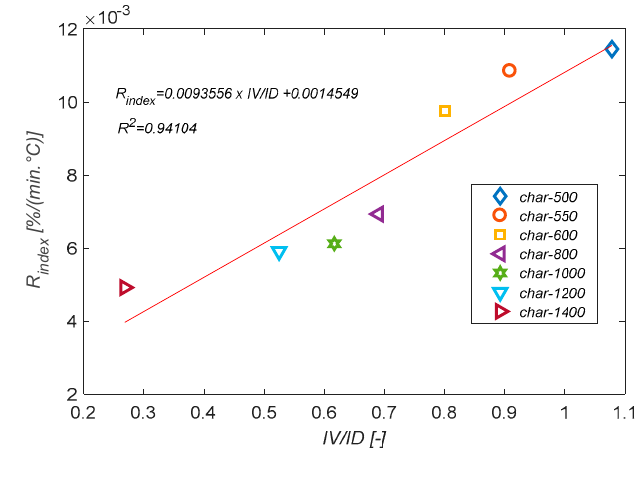
Figure 13. Evolution of (cid:1844) ((cid:3036)(cid:3041)(cid:3031)(cid:3032)(cid:3051)) with (cid:2893)(cid:2906)